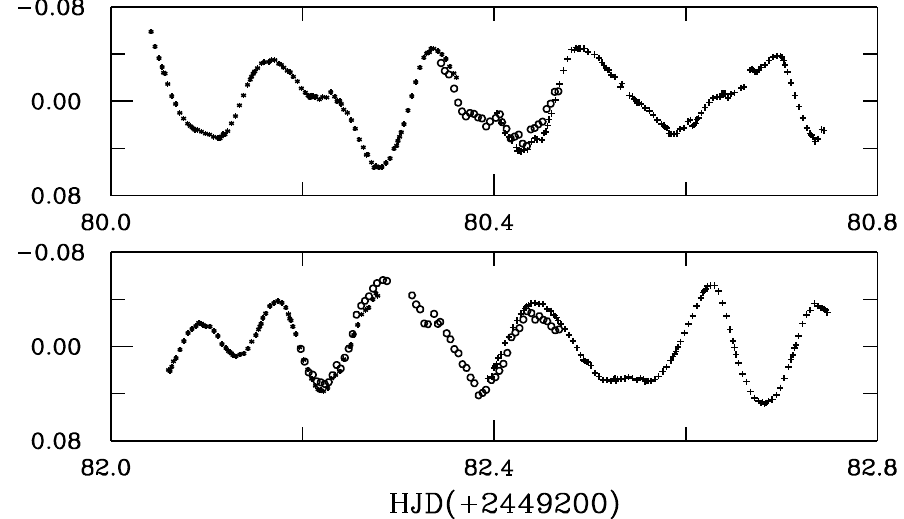
Fig. 3. Multi-channel photometry in Str¨omgren’s Δ v mag of δ Scuti type star VW Ari in Oct. 1993 jointly with STEPHI network: asterisks – data from Xinglong, China; open circles – data from Mt. Dushak-Erekdag, Turkmenistan; crosses – data from Teide,